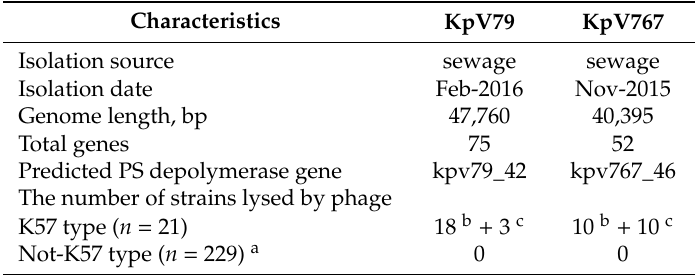
Table 1. General features of bacteriophages KpV79 and KpV767.